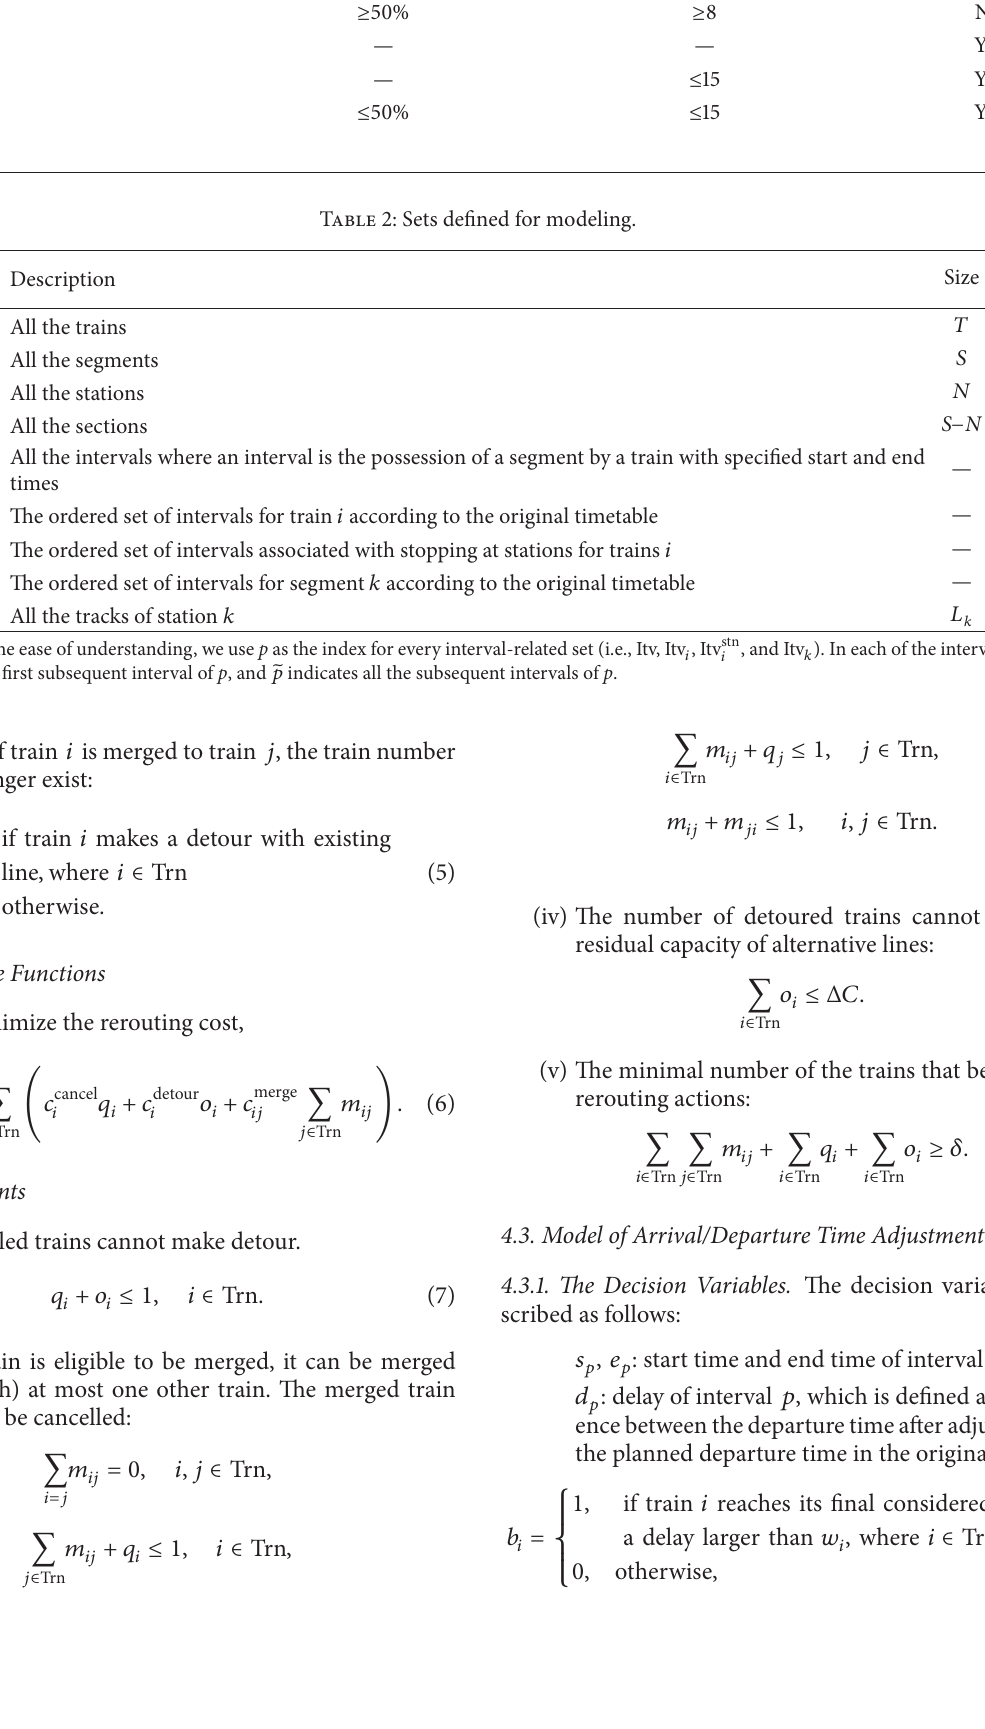
Table 1: Example of evaluation rules.